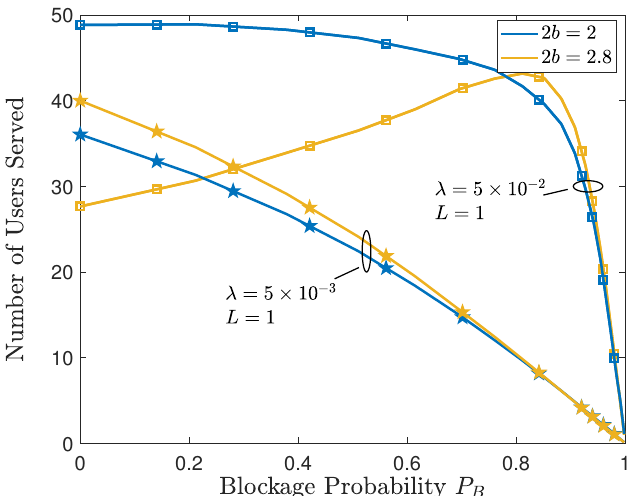
Figure 18. Average service probability vs. the probability or blockage of all the links, for λ = { 5 × 10 − 3 ,5 × 10 − 2 } m − 2 , and number of paths L = { 1,4 } , where L = 1 means that only LOS link exists. Parameters: [ P tx ] dB = 20 dB, NF = 7 dB, BW = 400 MHz, F c = 28 GHz, | β (cid:96) | = for every path (cid:96) , service area = 100m × 100 m square, AP height h = 10 m, SINR threshold [ T ] dB = 0, R max = 400